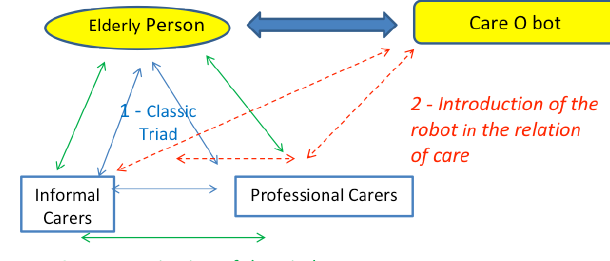
Figure 14. Role of robot in a traditional triad of